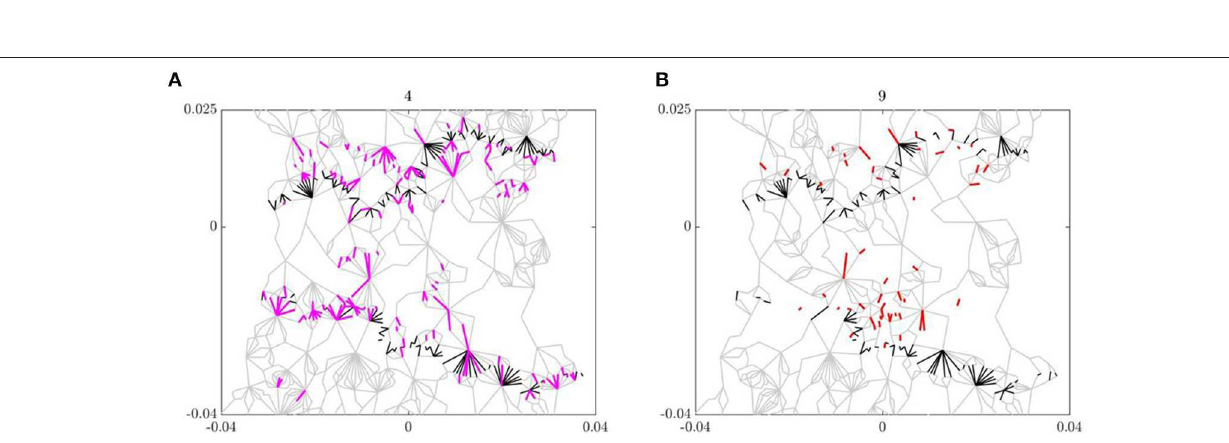
FIGURE 13 | (Color online) Force reroutes in P . (A) Spatial distribution of P for DI in the region of the bottlenecks at ǫ = 4: mobile links (magenta), other bottleneck contacts (black). (B) Spatial distribution of mobile links used to replace links lost to P across ǫ = 4 − 9 (red) shown with other bottleneck contacts (black). All other links of P are shown in